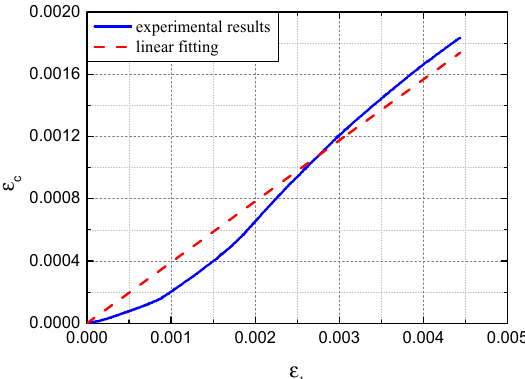
Figure 2. Calibration results of the strain transfer ratio of the adopted FBG sensors.